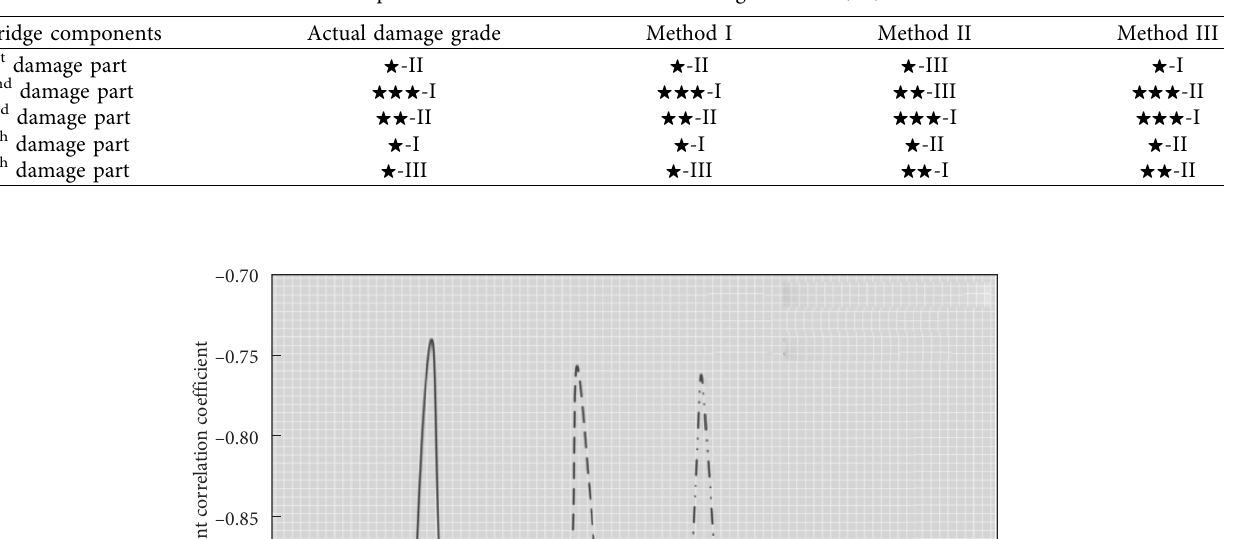
Table 1: Comparison of evaluation test results among methods I, II, and III.